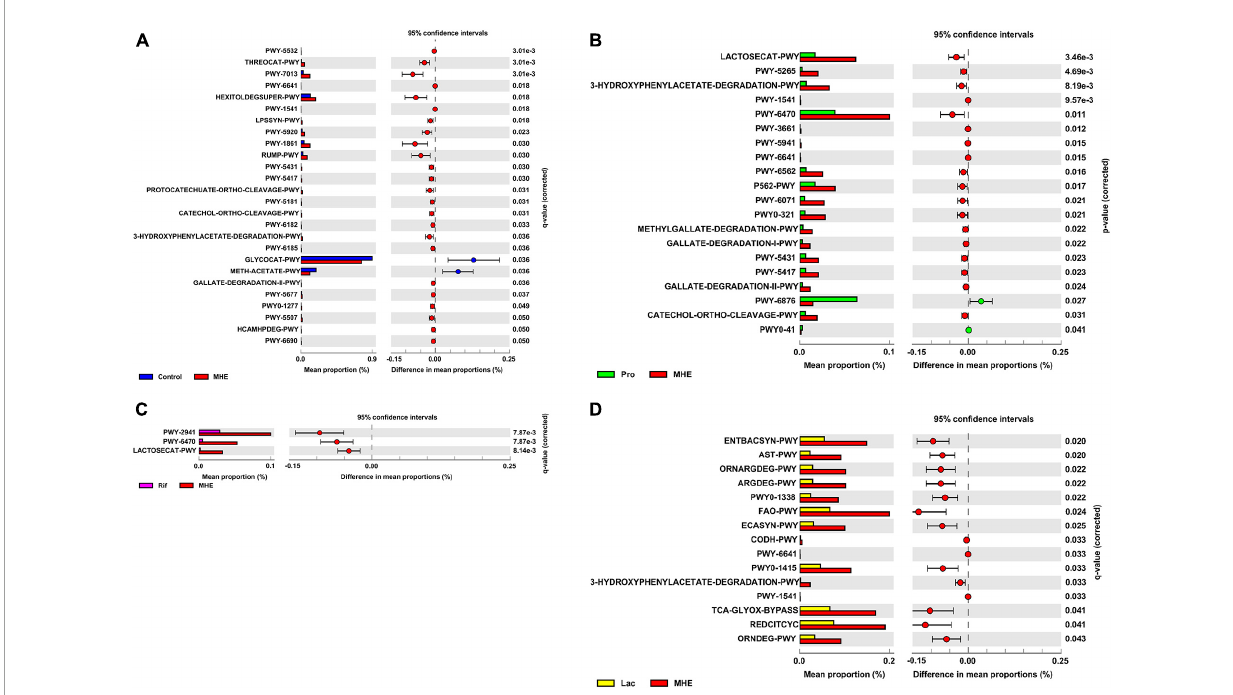
FIGURE5 Differential metabolic features in patients before and after treatment. Comparison of differential metabolic features between MHE patients and healthy controls (A) , MHE patients before and after probiotics treatment (B) , MHE patients before and after rifaximin treatment (C) , and MHE patients before and after lactulose treatment (D) . q -value, adjusted p -value by Benjamini–Hochberg method. If q -value is not significant, p -value is used.